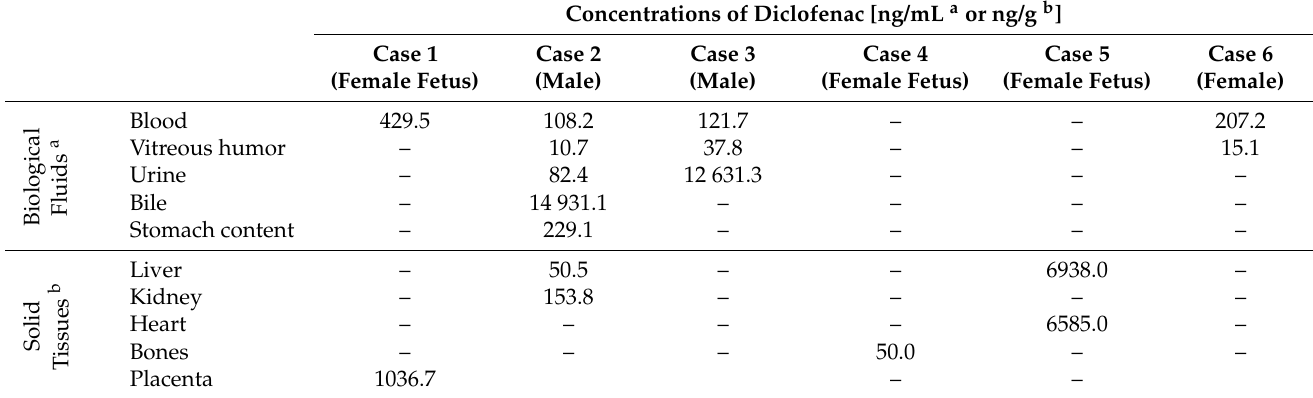
Table 3. Diclofenac concentrations in authentic forensic cases (biological fluids and